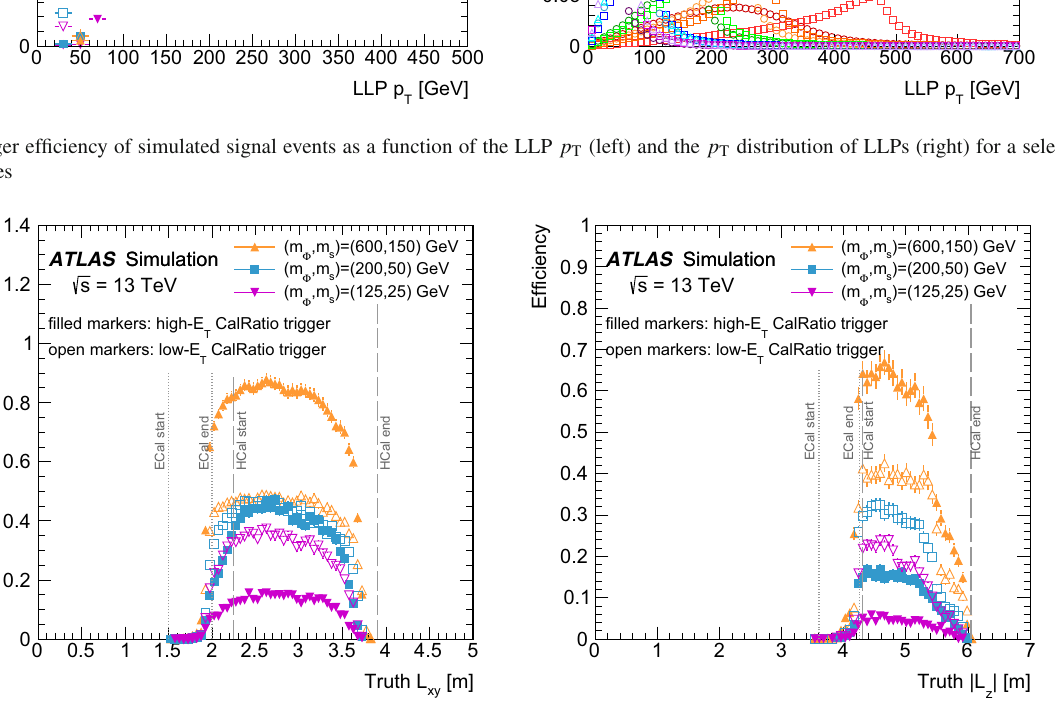
Fig. 2 Triggerefficiencyofsimulatedsignaleventsasafunctionofthe LLP decay position in the x – y plane for LLPs decaying in the barrel (left, | η | < 1 . 4) and in the z direction for LLPs decaying in the HCal